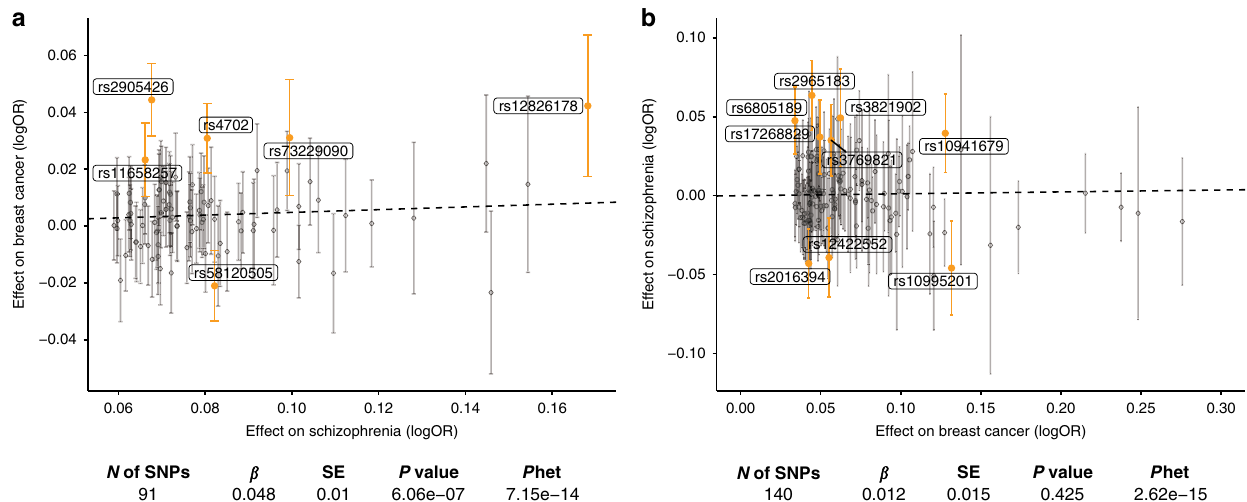
Fig. 2 Associations of lead SNPs for schizophrenia with the risk of breast cancer, and vice versa. a Lead SNPs for schizophrenia associated with breast cancer ( n = 122,977 breast cancer cases and 105,974 controls). b Lead SNPs for breast cancer associated with schizophrenia ( n = 36,989 schizophrenia cases and 113,075 controls). We plotted the associations of genetic markers for one disease (the effect size shown as X axis) with the other disease ( Y axis) based on GWAS summary statistics. Data are presented as OR (dots) and 95% con fi dence interval (error bars). Orange dots denote variants of P < 0.05 after false discovery rate (FDR) adjustment. We then derived the average effect of the set of genetic markers on the other disease using a global test. The dash line indicates this effect size, while the full statistical results were reported below the plot. P values are two sided. N number, OR odds ratio; P het, P for heterogeneity, SD standard deviation, SE standard error, SNP single-nucleotide